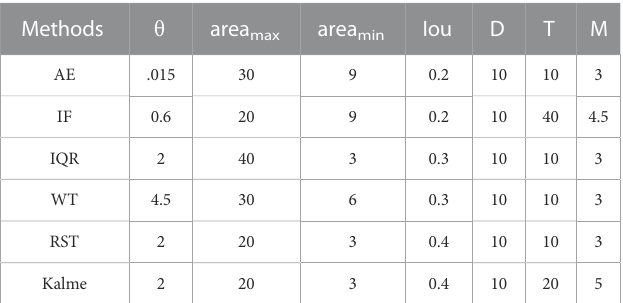
TABLE 4 The optimal parameters for each